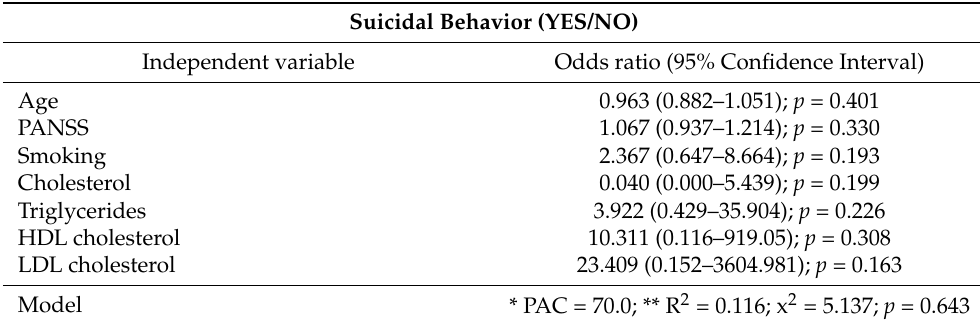
Table 6. Suicidal behavior in aggressive patients with schizophrenia depending on age, severity of symptoms of schizophrenia (PANSS), smoking, and lipid